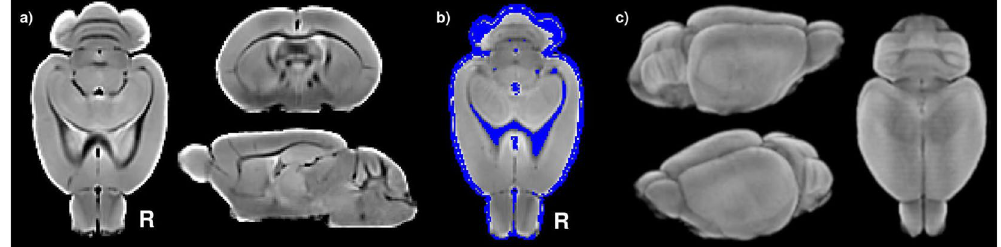
Figure 1. Prairie vole brain template unbiased for shape and intensity 63 . ( a ) axial, coronal and sagittal slices of the isotropic brain template (0.125 mm per voxel side). ( b ) Non-grey matter binary mask (blue), including most of the WM and CSF, overlayed on the brain template. ( c ) 3D-render of the prairie vole brain